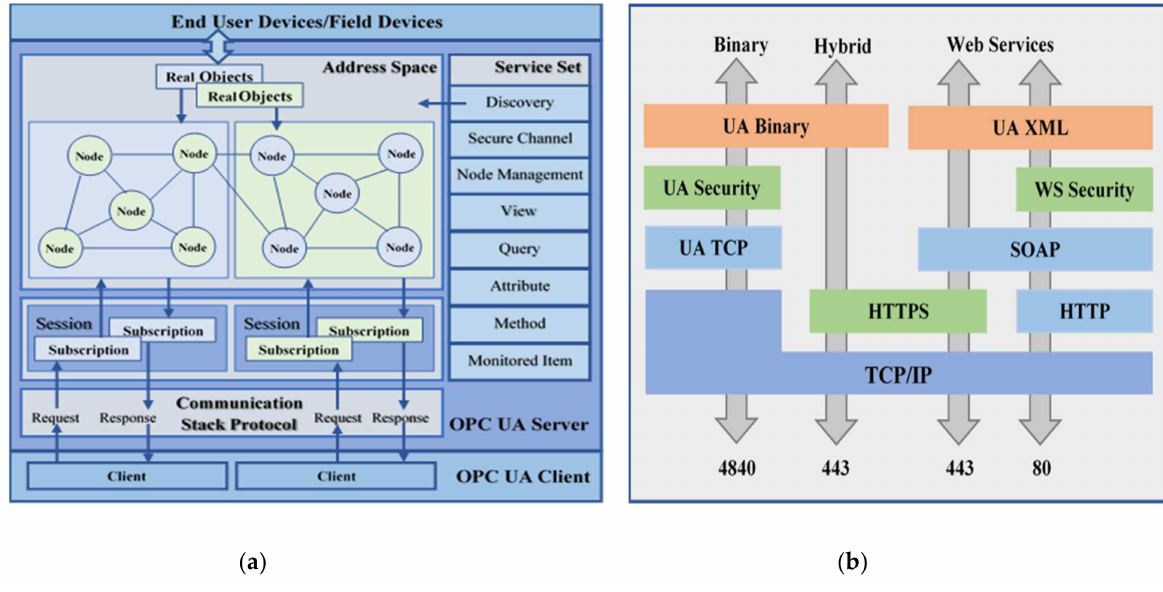
Figure 2. OPC UA server–client model: ( a ) structure; ( b ) data transport